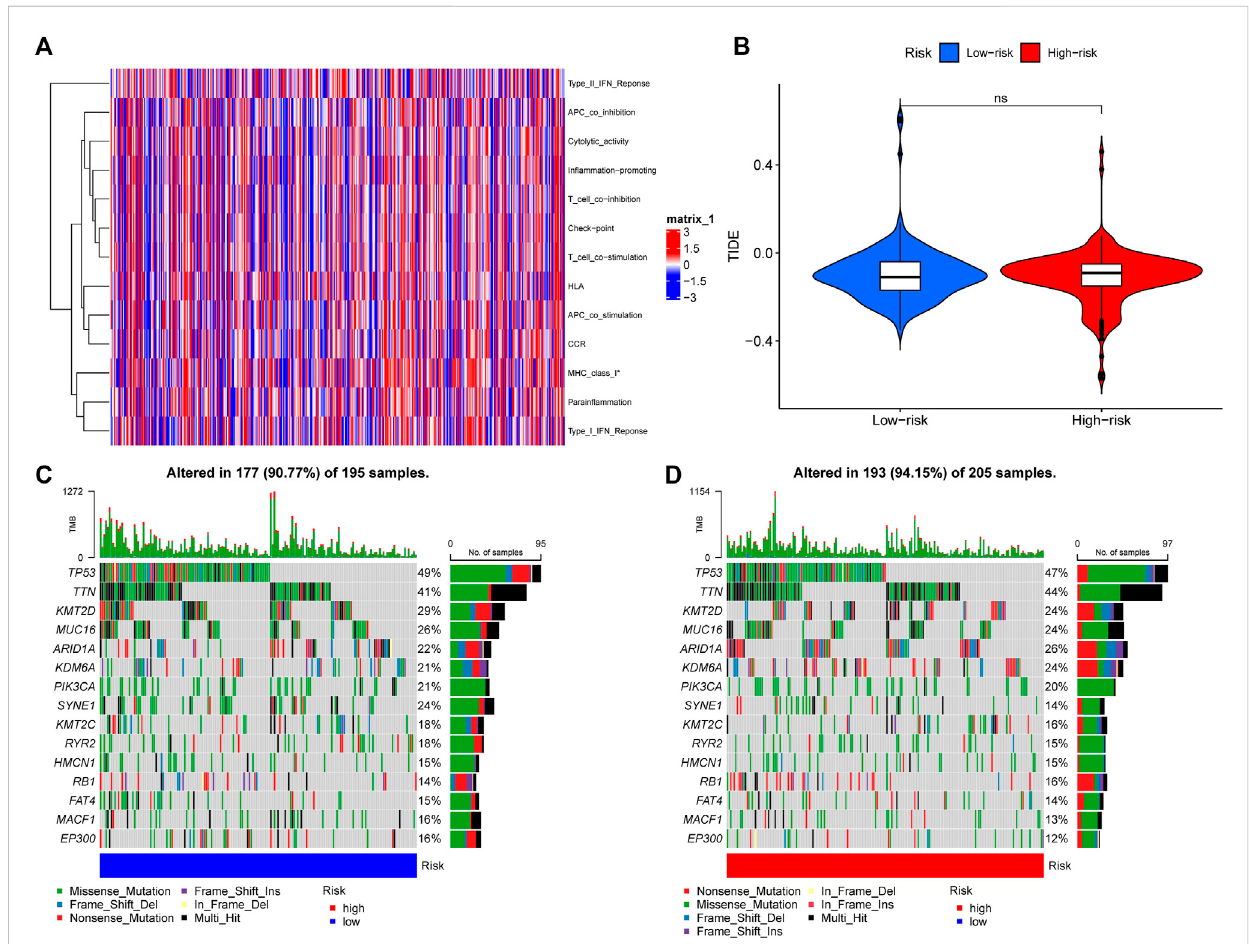
FIGURE 7 Immune-related function analysis and gene mutation frequency comparison (A) The heatmap shows prominent differences in 13 immune-related functions between high- and low-risk groups. * p < 0.05 (B) TIDE between high and low-risk groups, TIDE, tumor immune dysfunction and exclusion. Ns means not signi fi cant. The waterfall plots show somatic mutations of the most obvious 15 genes between low-risk (C) and high-risk (D) BLCA patients.